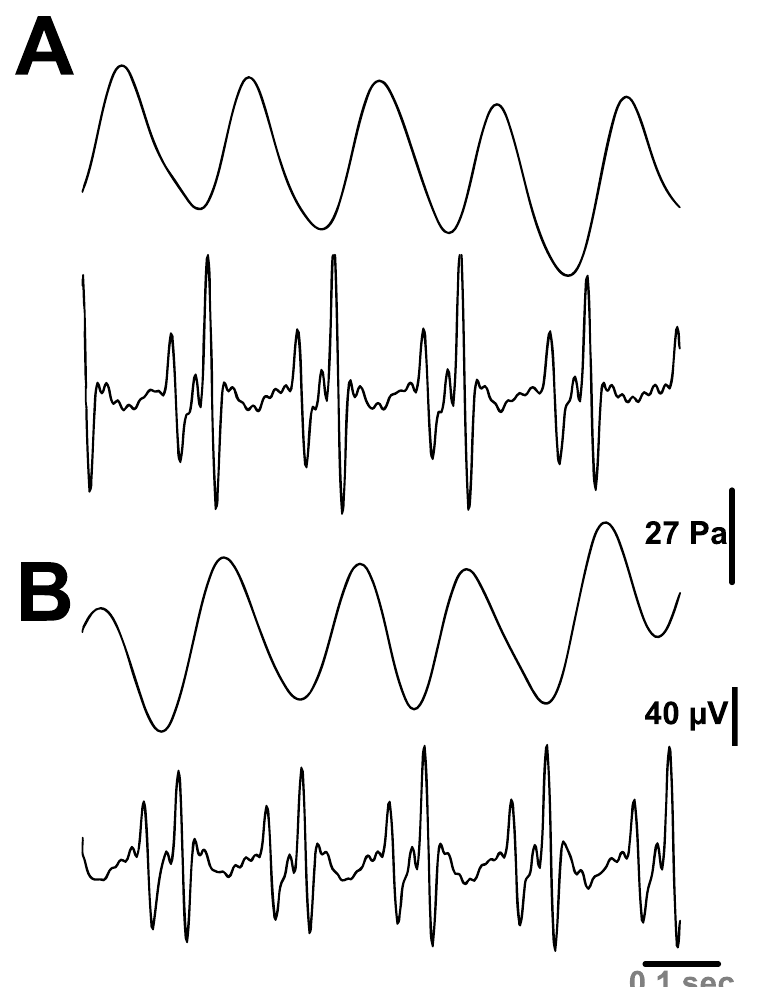
Fig 3. Spontaneous rhythmic contractions (pulse pressure) of the aorta correlated to ECG. (A, B) Representative tracings of aortic contractions (upper panel) and ECG recording (lower panel) before (A) and after (B) bleeding the